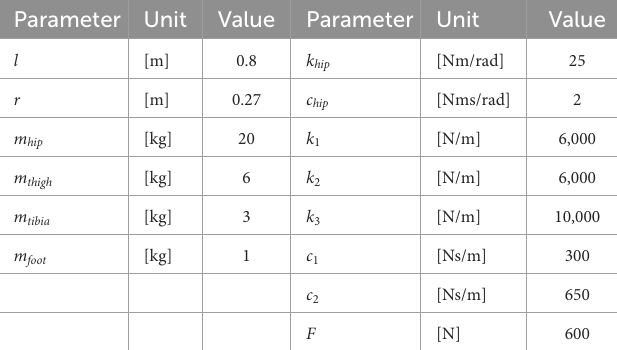
TABLE 1 Parameters of the bipedal